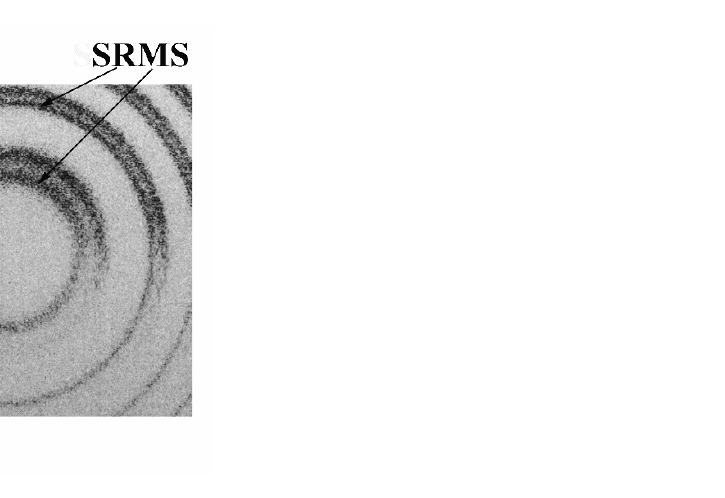
Figure 5. Typical Fabry–Perot spectra in the case of nanosecond pulses: pump ( lower part ), backscattered Brillouin and Rayleigh signals ( upper part ).